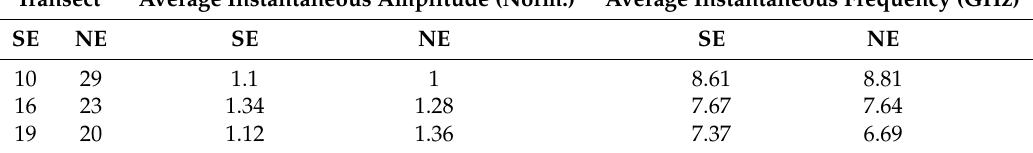
Table 3. Normalized average instantaneous amplitude and frequency for three pairs of transects in each leg, one in the center (10 and 29), at the edge (19 and 38), and midway between an air void and post-tensioned tendon. Average Instantaneous Amplitude (Norm.)